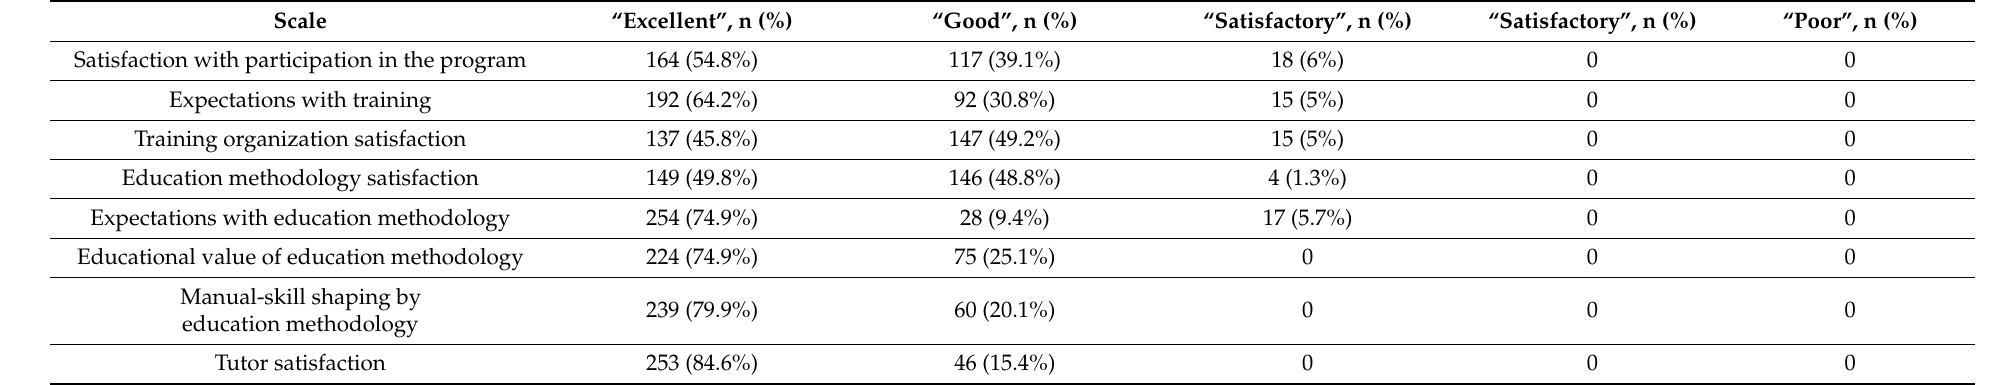
Table 1. Analysis of the distribution of main group participants’ opinions on training (n = 299).